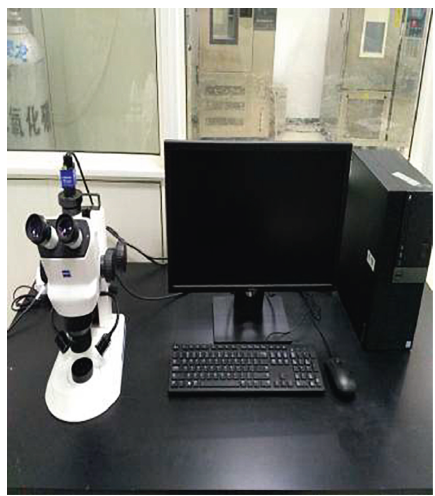
Figure 8: Stemi 508 stereo microscope.